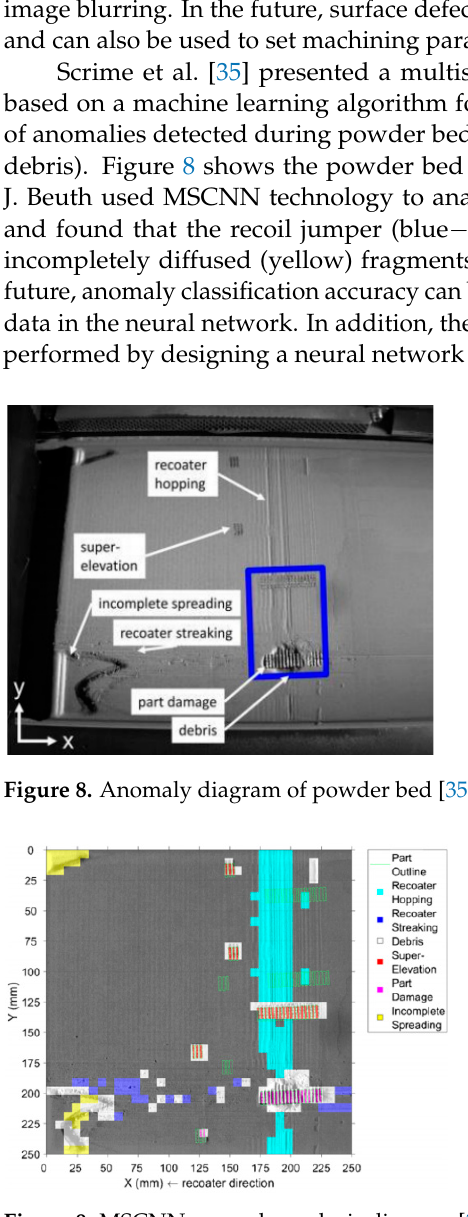
Figure 9. MSCNN anomaly analysis diagram [35].